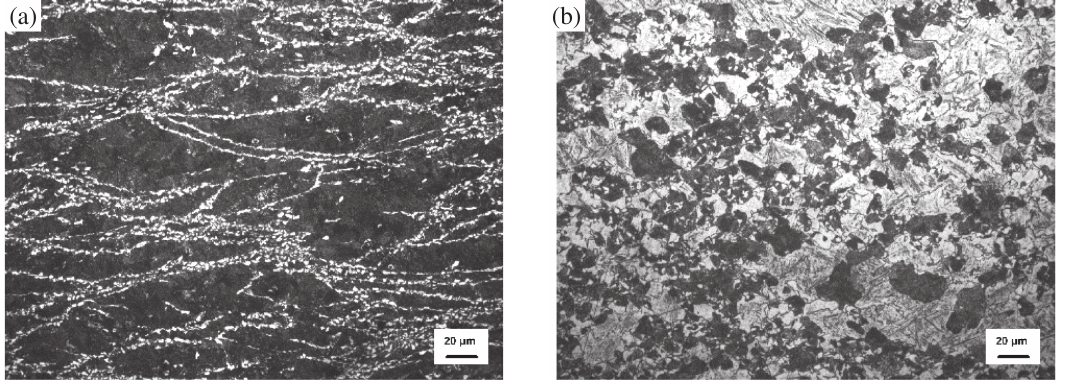
Figure 9: Microstructures of 49MnVS3 non-quenched and tempered steel deformed at the strain rate of 0.1 s − 1 and temperature of (a) 750 °C and (b) 850°C.